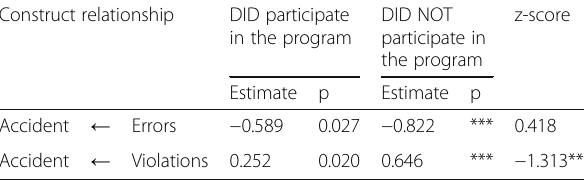
Table 4 Critical ratios of comparison between groups Construct